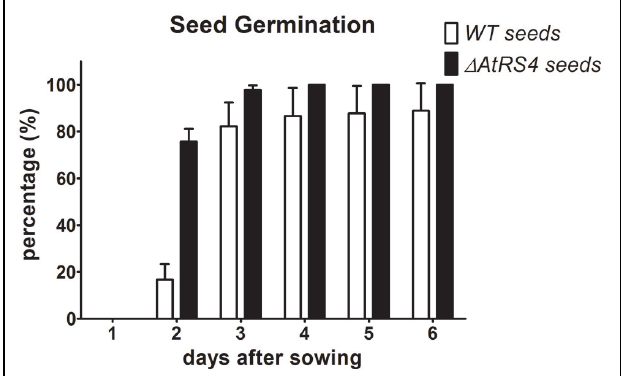
FIGURE 11 | Kinetic of WT and (cid:2) AtRS4 seed germination. WT and (cid:2) AtRS4 mutant seeds for germination experiment were sowed on 0.5% plant agar and grew under control growth conditions. Germination was defined as the time between sowing and protrusion of the radicle. Values are averages of three independently performed experiments ( ±